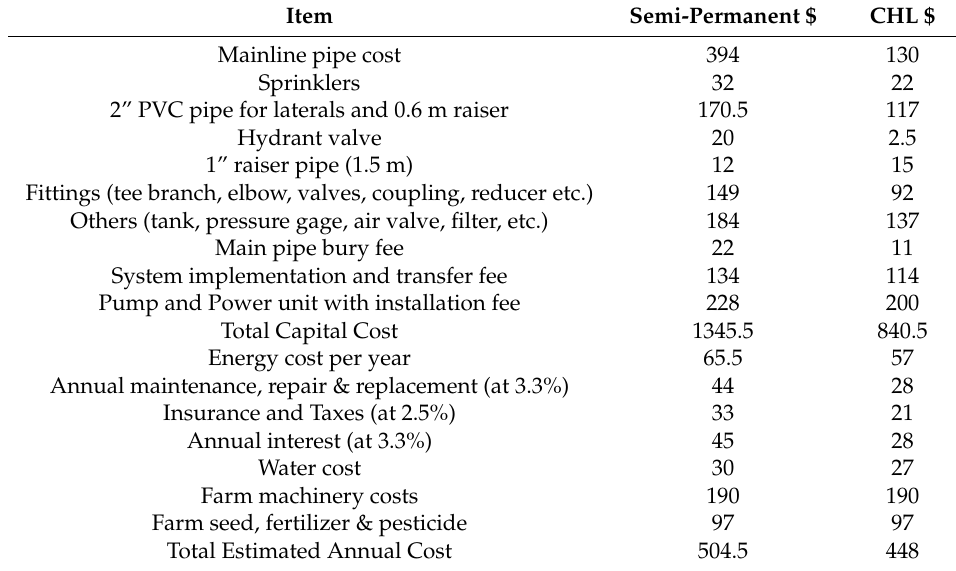
Table 3. Semi-permanent and CHL cost comparison for a 2-acre farm in